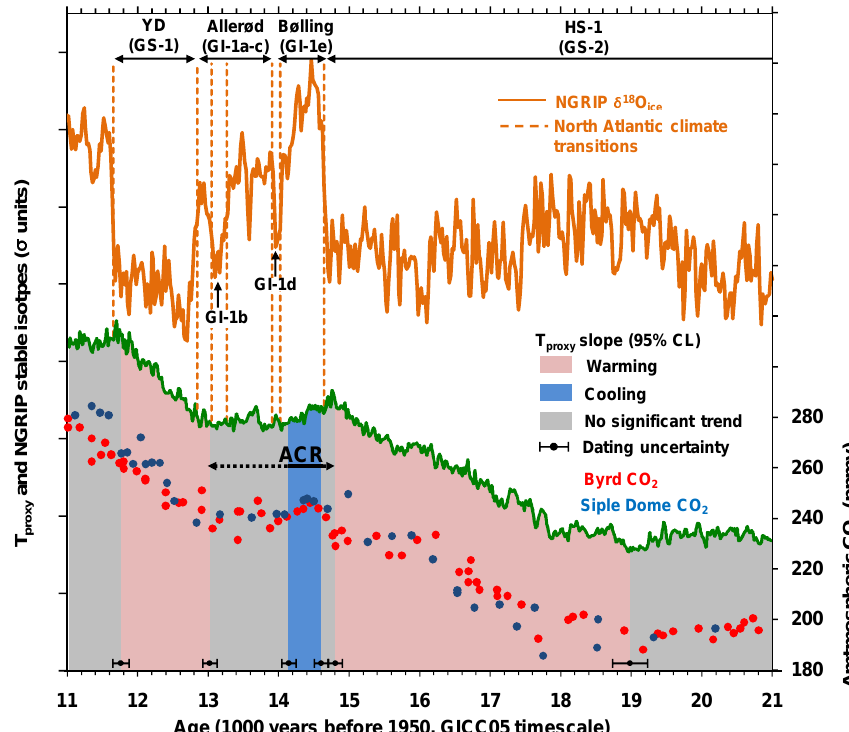
Fig. 3. Atmospheric CO 2 and the bipolar seesaw on the GICC05 timescale. Significant warming and cooling trends in T proxy are represented by coloured vertical bands, adopted from a previous study (Pedro et al., 2011). Climate in the North Atlantic region is represented by the NorthGRIP ice core δ 18 O record (Lowe et al., 2008). Changes in the slope of T proxy are synchronous with climate transitions in the North Atlantic (vertical orange lines) within relative dating uncertainties (horizontal error bars). The deglacial increase in CO 2 occurs in two steps, corresponding to the significant warming trends in T proxy (pink bands). A pause in the CO 2 rise is aligned with a break in the warming trend (central grey band) during the Antarctic Cold Reversal (ACR). Within the core of the Antarctic Cold Reversal, significant cooling in T proxy (dark blue band) coincides with an apparent decrease in CO 2 . Fast-acting inter-hemispheric coupling mechanisms linking Antarctica, Greenland and the Southern Ocean are required to satisfy these timing